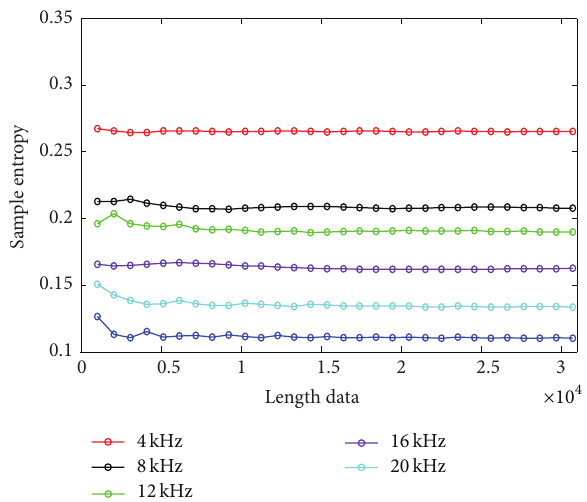
Figure 7: The calculated SampEn values by different parameters (length of the data and the sample frequency).